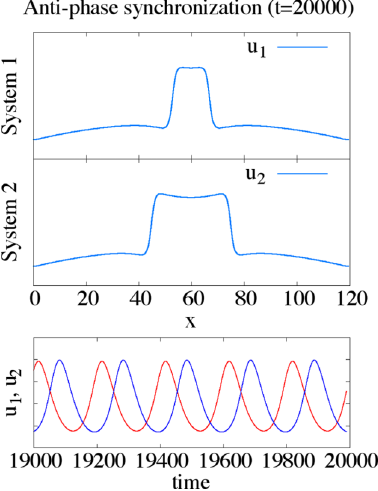
VIDEO 2. Antiphase synchronization of oscillating spots in a 1D system of length L ¼ 120 . The parameters are the same as in Fig. 2. The initial phase difference is ϕ ð 0 Þ ¼ 1 . 61 . The bottom figure shows the evolution of the activator variables ð u 1 ; u 2 Þ at the center ( x ¼ L= 2 ) of both systems.